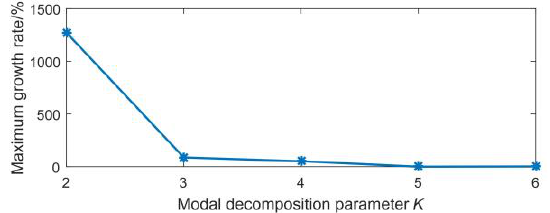
Figure 8. The change of maximum growth rate Δ under different values of K.